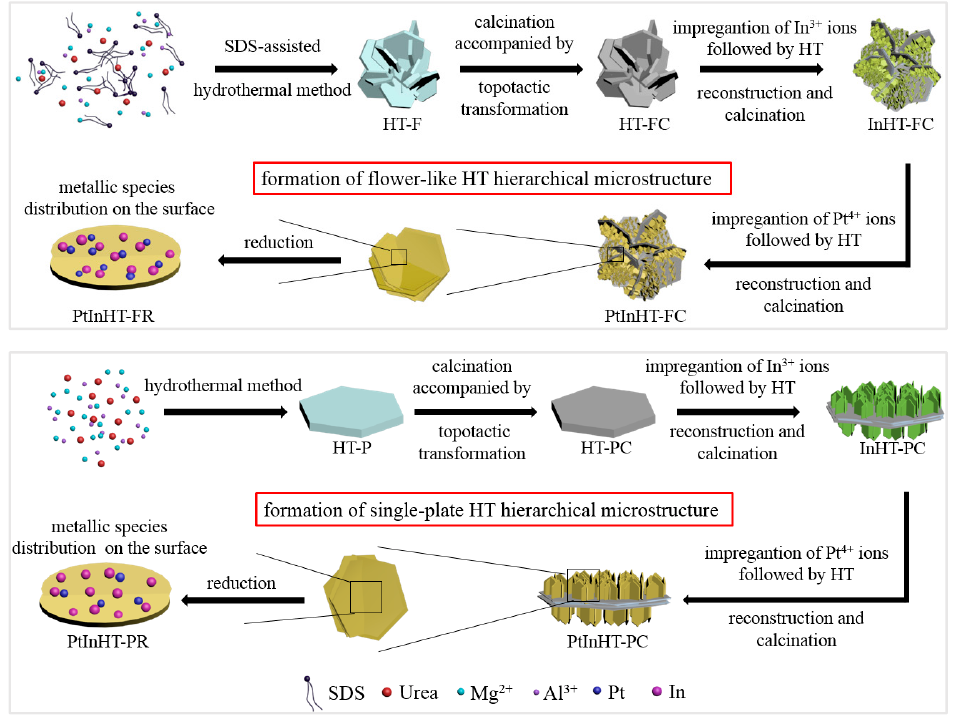
Scheme 1. Schematic illustrations of the formation of the ball-flower-like and single-plate hierarchical